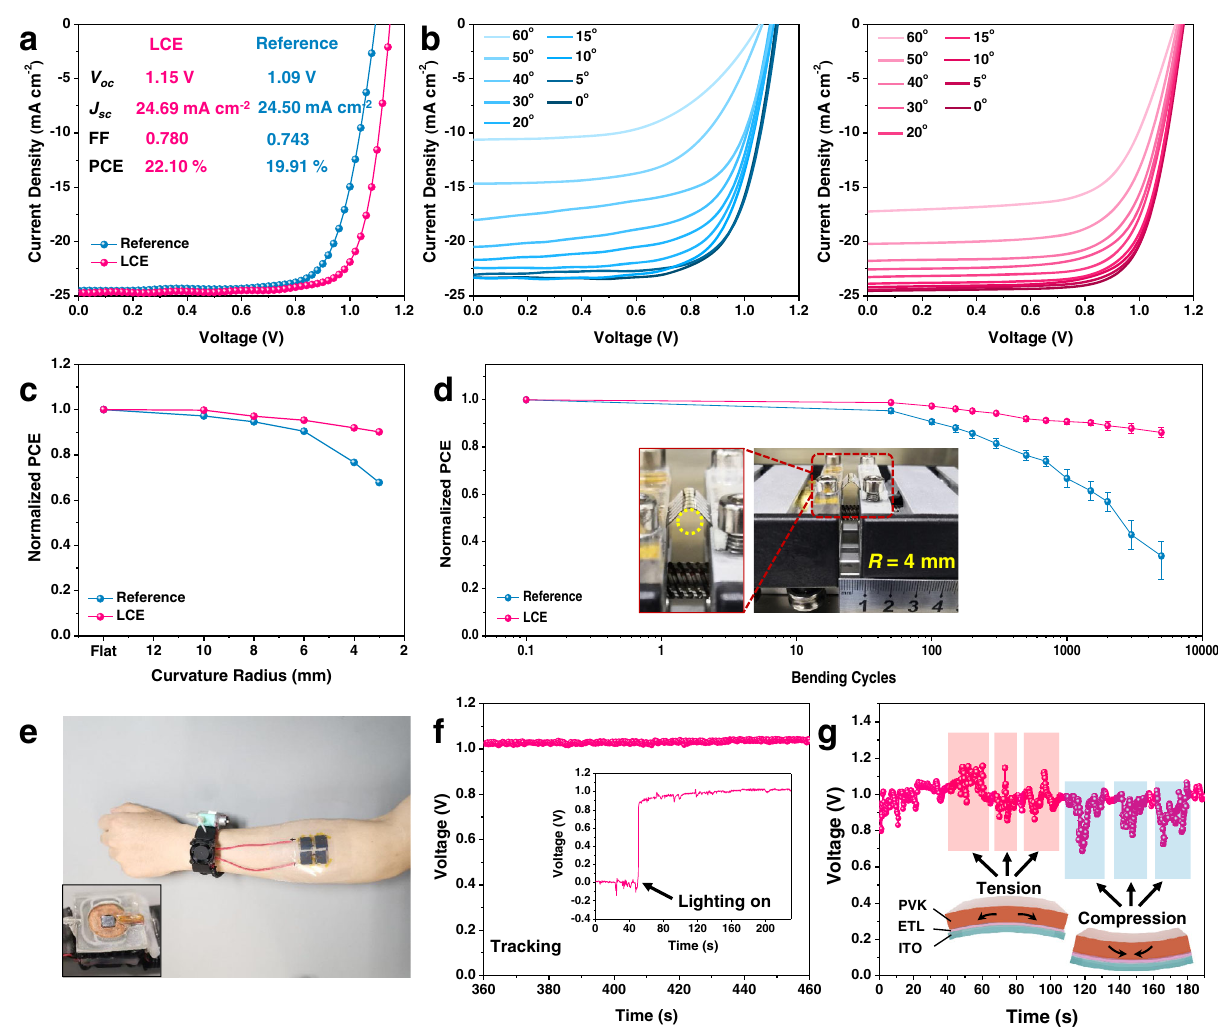
Fig. 4 | Performance of fl exible PSCs. a J – V curves of the champion fl exible PSCs based on LCE and reference, respectively. b J – V curves measured at different bendinganglesforreferenceandLCE-based fl exiblePSCs. c NormalizedPCEvalues of fl exiblePSCsafterbending500cycleswithdifferentbendingradii. d Normalized average PCE values for fl exible PSCs as a function of bending cycles with the bending radius of 4mm. e Photographic image of the IoT system basedon fl exible